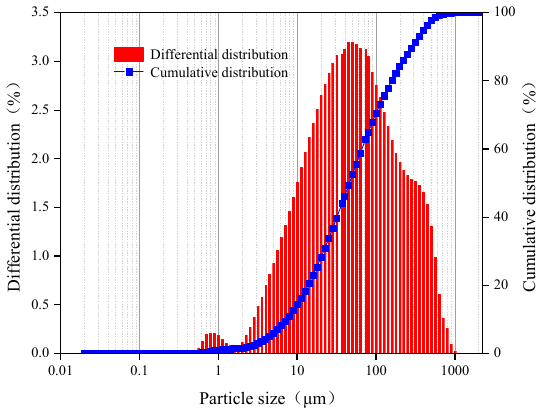
Figure 1. Particle size distribution of tailings. Table 1. Physical properties of tailings.